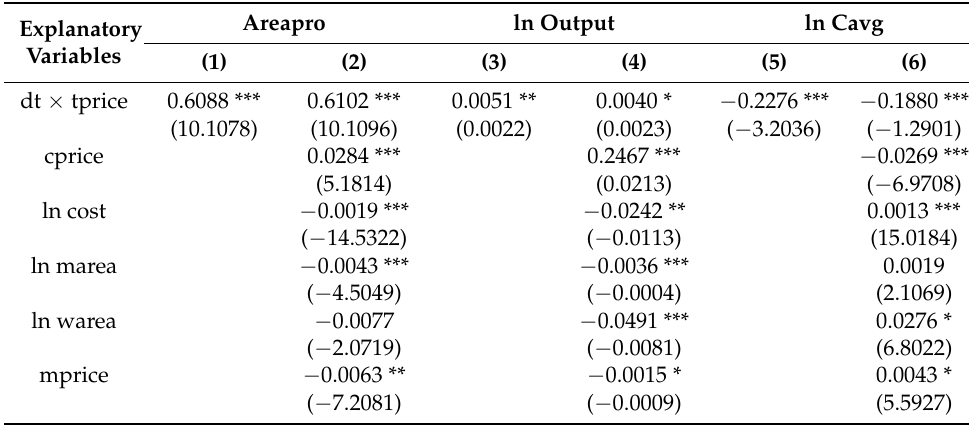
Table 3. The impact of target price policy on cotton